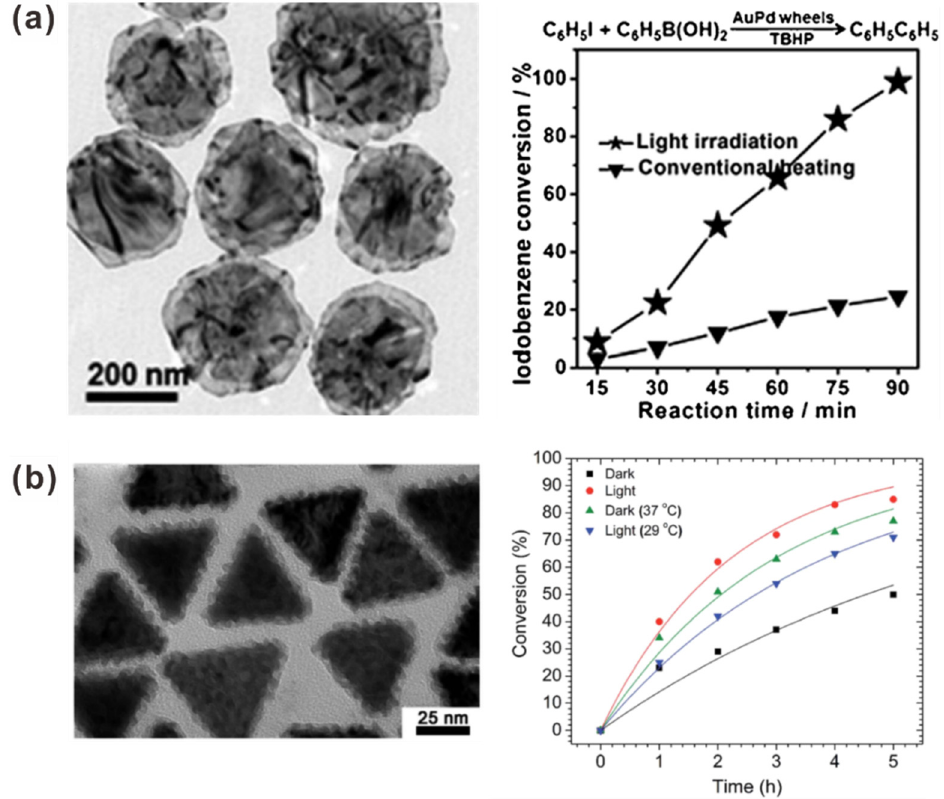
Figure 7. Au–Pd bimetallic alloys for photocatalytic Suzuki coupling. ( a ) AuPd nano-wheels. Reproduced with permission from Reference [98]. Copyright 2013 Wiley-VCH. ( b ) AuPd nanotriangles. Reproduced with permission from Reference [99]. Copyright 2017 Royal Society of Chemistry.